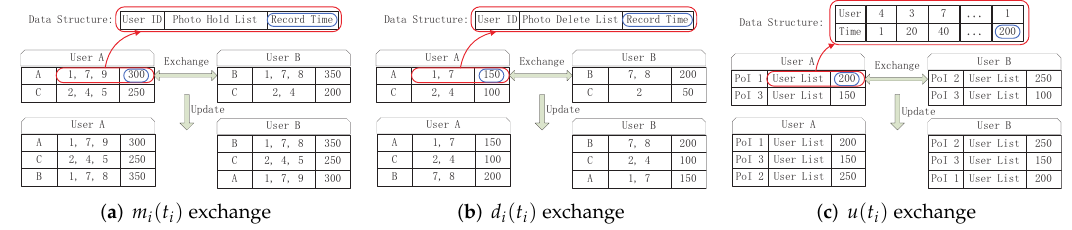
Figure 10. Parameter collection process to estimate m i ( t i ) , d i ( t i ) , and u ( t i )